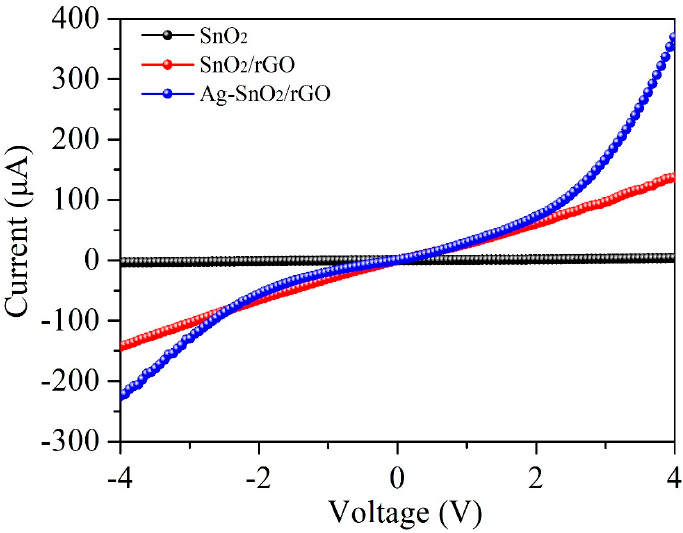
Figure 10. The measured I–V curves of the SnO 2 , SnO 2 /rGO and Ag–SnO 2 /rGO films.